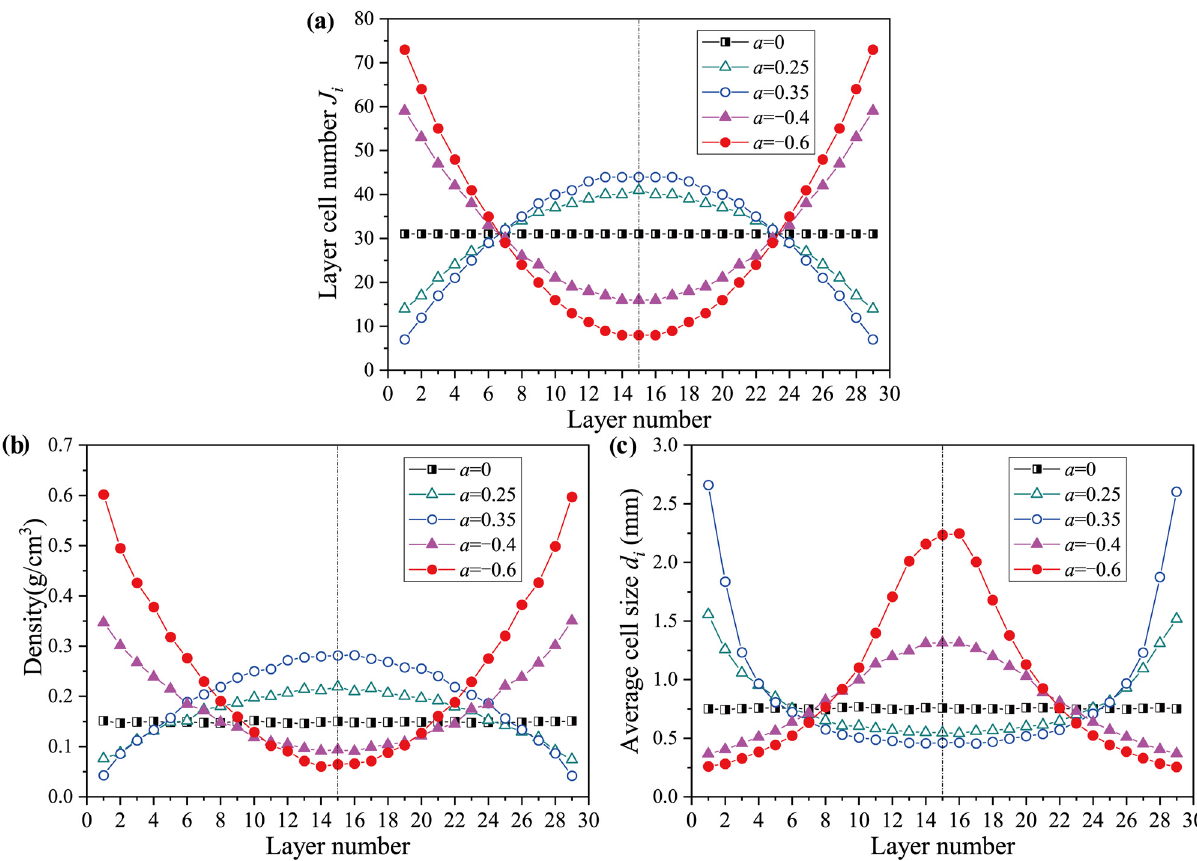
Figure 2: Distribution curve of the ( a ) layer - cell - number J i , ( b ) layer - density, and ( c ) layer - cell - size versus grid layers. The total number of cells N = 900 ± 5; number of grid layers I = 29; the radius coe ffi cient of the spreading circle λ = 1/3. All Voronoi models have a relative density of